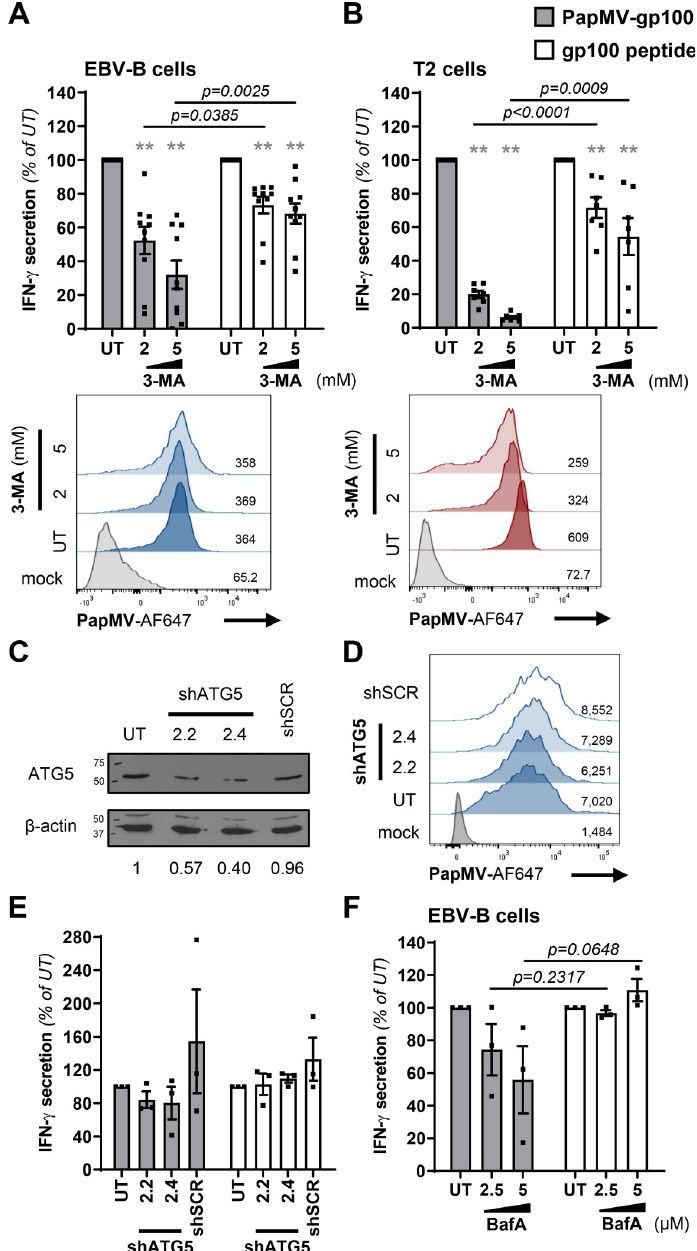
Fig 4. MHC class I antigen cross-presentation mediated by PapMV VLPs is dependent on autophagy induction. EBV-B and T2 cells were pretreated for 1 hour with 3-MA (A, B) or bafilomycin A (BafA; F ) at indicated concentrations. PapMV-gp100 (50 μ g/mL) or gp100 peptide (1 μ M) were added to pretreated cells without washing and cells were incubated for 6 hours at 37˚C. Cells were washed and co-cultured with gp100-specific CD8 + T lymphocytes for 16–18 hours at a 1:1 ratio. Supernatants were collected and IFN- γ secretion was quantified by ELISA to evaluate MHC-I antigen cross-presentation. Results are presented as mean ± SEM, % of IFN- γ secretion compared to untreated cells from ten (A) , seven (B) and three (F) independent experiments. (C-E) EBV-B cells were transduced with lentivirus expressing mAmetrine and shRNA targeting ATG5 mRNA (clones 2.2 and 2.4) or scramble shRNA (shSCR). After expansion of transduced cells, mAmetrine + cells were sorted by flow cytometry. (C) ATG5 knockdown was evaluated by western blot. Cells were collected, protein extracted and resolved by SDS-PAGE using a 10% acrylamide gel. ATG5 and β -actin were revealed by specific antibodies on the same membrane. Scanned images of the blot were cropped between 50 kDa and 75 kDa for ATG5 and 37 kDa and 50 kDa for the β -actin loading control and are representative of two independent experiments. Full-length blots are presented in S5 Fig. Numbers